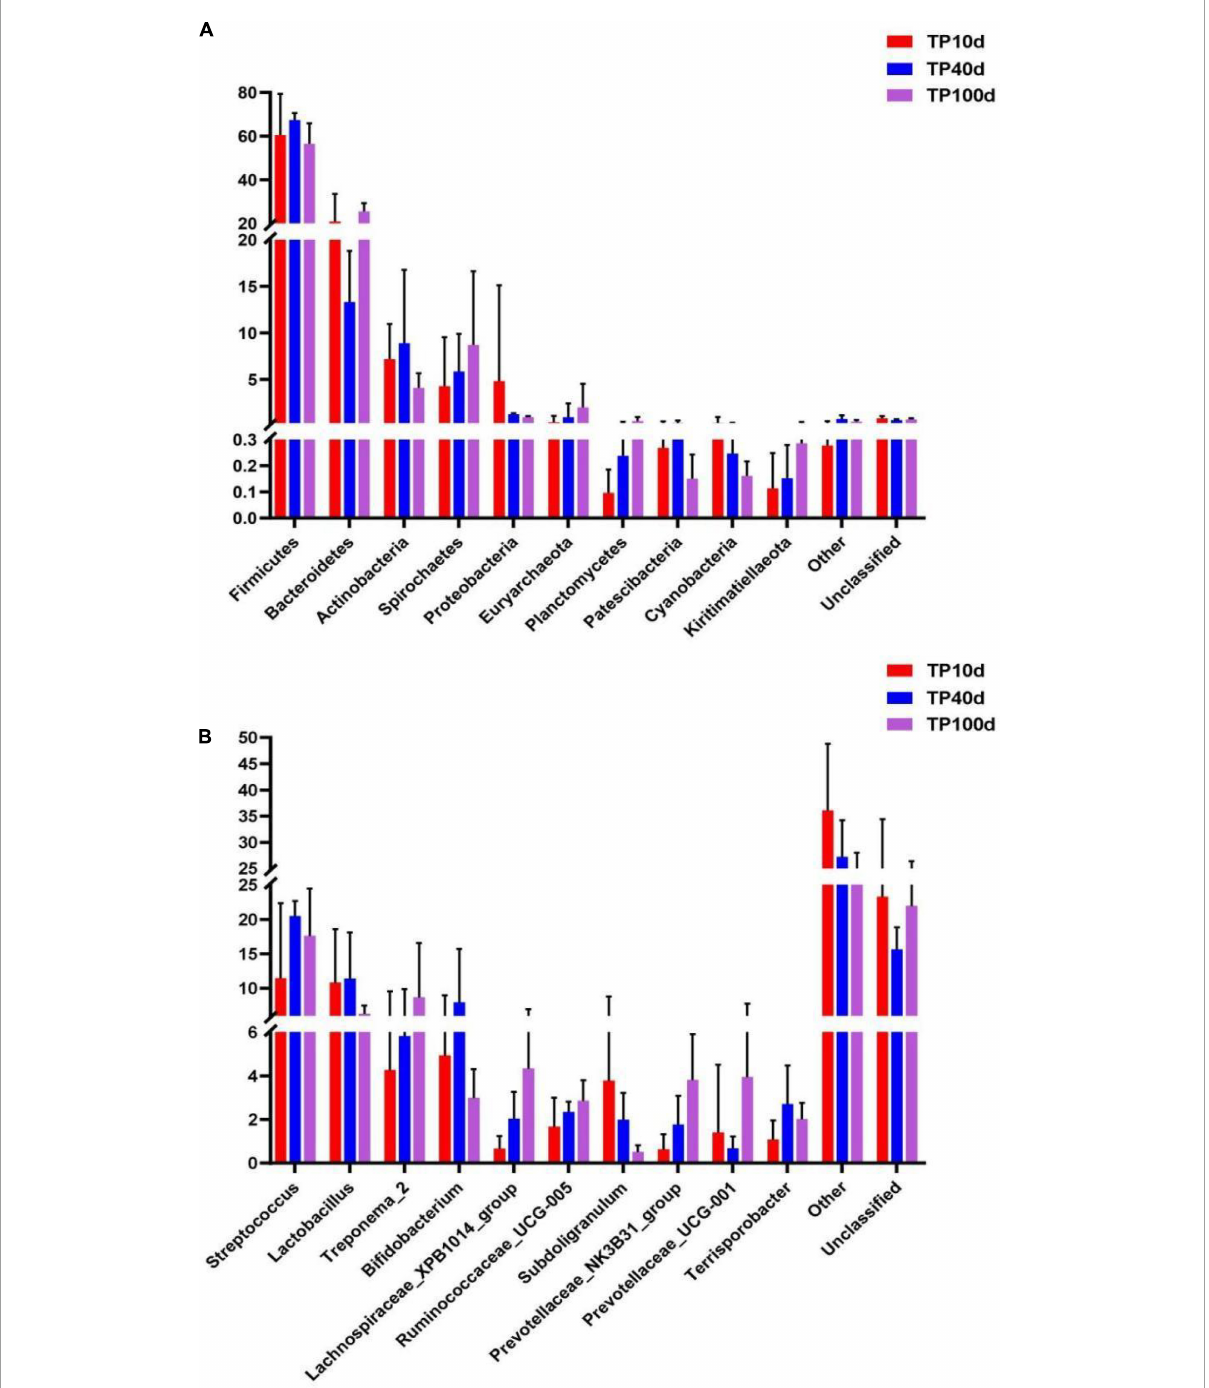
FIGURE4 Comparison of community differences in intestinal microbial composition between Tibetan pigs. At phyla level (A) and genus level (B) . All data represent